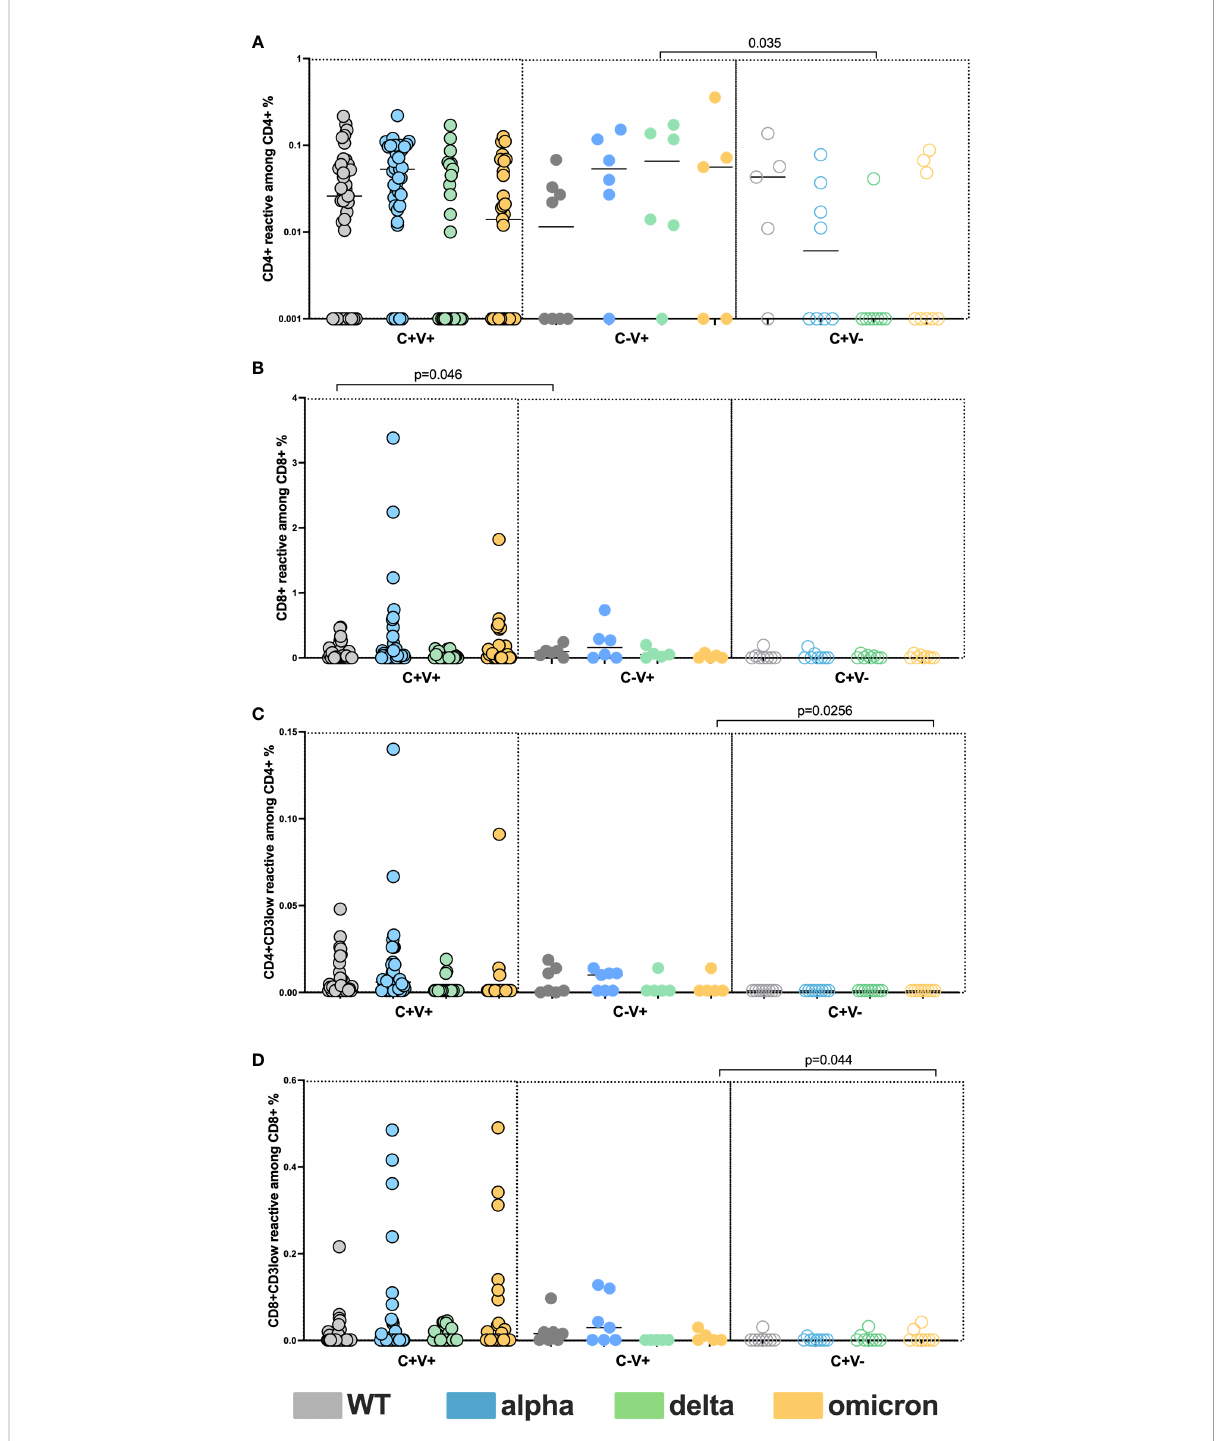
FIGURE 4 Preserved cross-reactive T cell memory among C+V+, C-V+ and C+V-. Comparison of WT, alpha, delta and omicron-reactive T cells among C+V+, C-V+ and C+V. (A) Frequencies of SARS-CoV-2 reactive CD4+ T cells. (B) Frequencies of SARS-CoV-2 reactive CD8+ T cells. (C) Frequencies of SARS-CoV-2 reactive CD4+CD3low+ T cells. (D) Frequencies of SARS-CoV-2 reactive CD8+CD3low+ T cells. Scatterplots show line at median. Unpaired data were compared with